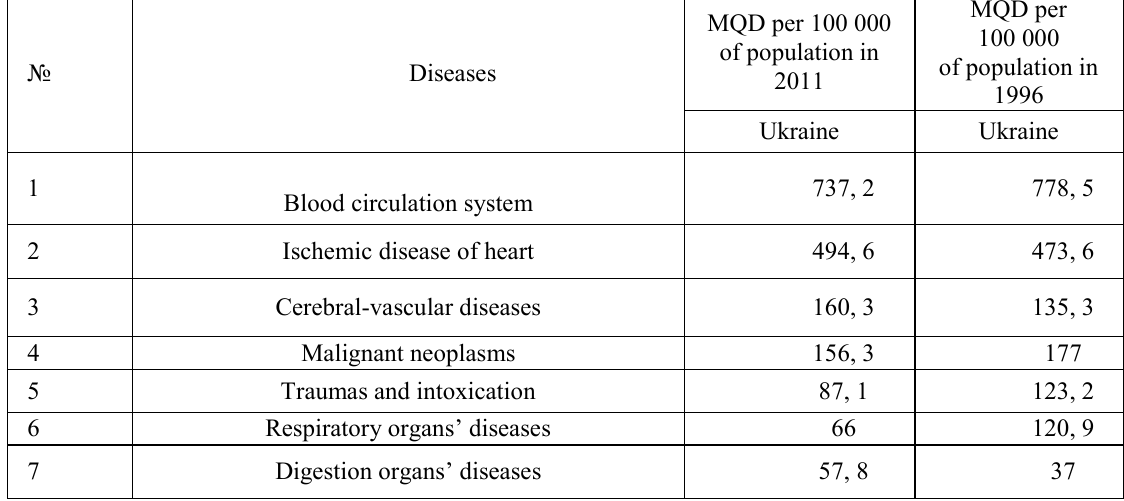
Fig.2. The structure of diseases prevalence among workable population of Ukraine (%) Sub-quality treatment and rehabilitation result in disability and mortality. We interested in the level of mortality after diseases of respiratory organs. As per the data of Center of medicine statistics, in 2010, by mortality, respiratory organs’ diseases were on 6 th place after diseases of blood circulation systems, neoplasms, traumas and intoxication, cerebral-vascular and ischemic diseases of heart. With it, mortality owing to respiratory organs’ diseases two times reduced comparing with 1996, but still, against the background of all diseases it takes 6 th place in Ukraine. The characteristic of mean quantity of deaths (MQD) is presented in table 2 and in fig.2. MQD (mean quantity of deaths) per 100 thousand of